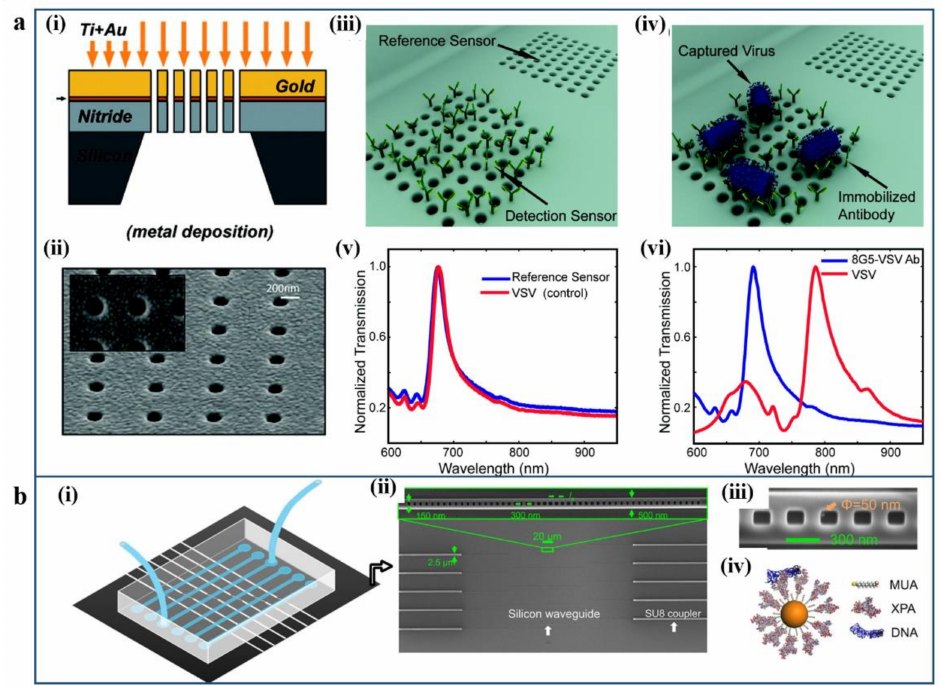
Figure 6. Examples of nanoholes or cavity array-based plasmonic sensing platforms. ( a ) Label- free pattern nanoholes array based in an optofluidic device for the direct detection of live viruses. ( i ) Schematic of plasmonic nanohole arrays fabricated by metal deposition and ( ii ) SEM image of nanohole array sensor. ( iii , iv ) The schematic illustration and ( v , vi ) the EOT transmission spectrum of antibody functionalized nanohole array biosensor. Reproduced with permission from [101]. Copy- right 2010 American Chemical Society. ( b ) A hybrid photonic–plasmonic antenna-in-a-nanocavity biosensor for single-molecule DNA–protein dynamics detection. ( i ) Schematic illustration of the hy- brid biosensing system. ( ii ) SEM image of the silicon photonic chip with multiplexed photonic crystal nanobeam cavities and connected by waveguiding components. ( iii ) SEM image of the photonic crystal nanobeam cavity. ( iv ) Illustration of the biofunctionalized gold nanoparticle. Reproduced with permission from [102]. Copyright 2017, American Association for the Advancement of